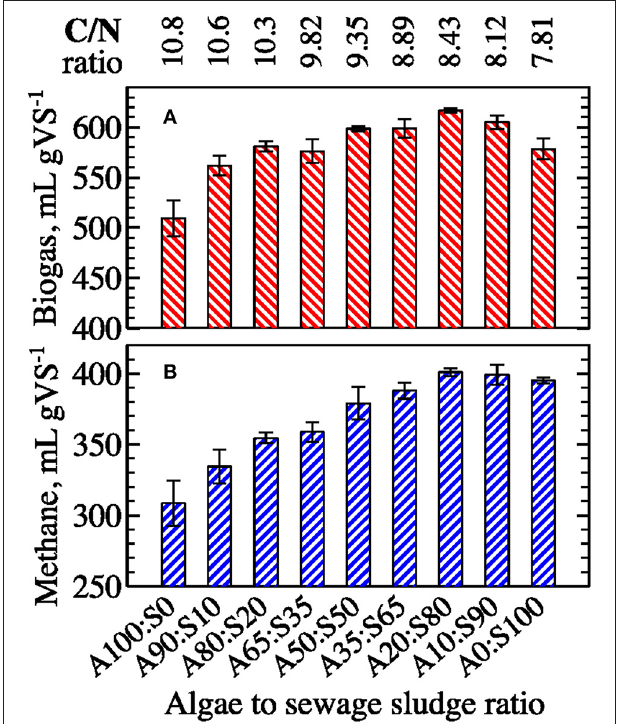
FIGURE 7 | Effect of algal co-digestion with sewage sludge (percent of Algae to percent of Sludge in the mixture) on ultimate specific biogas (A) and methane (B) yields (error bars represent 1 S.D. for three